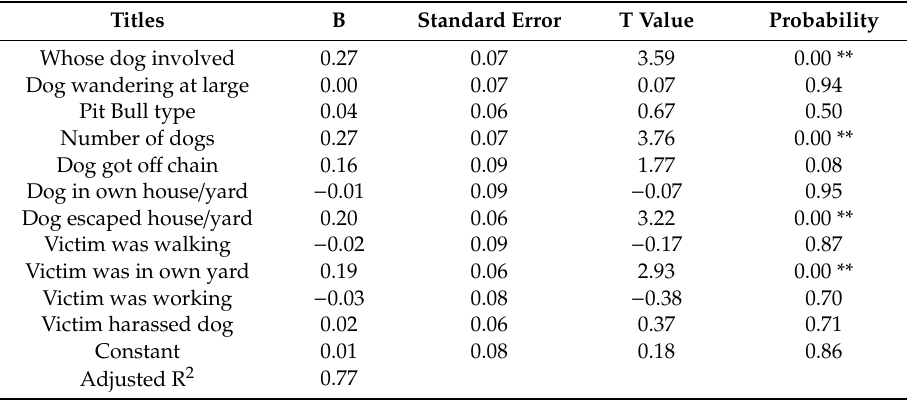
Table 2. Regression, dog bites by nature of dog and circumstances.